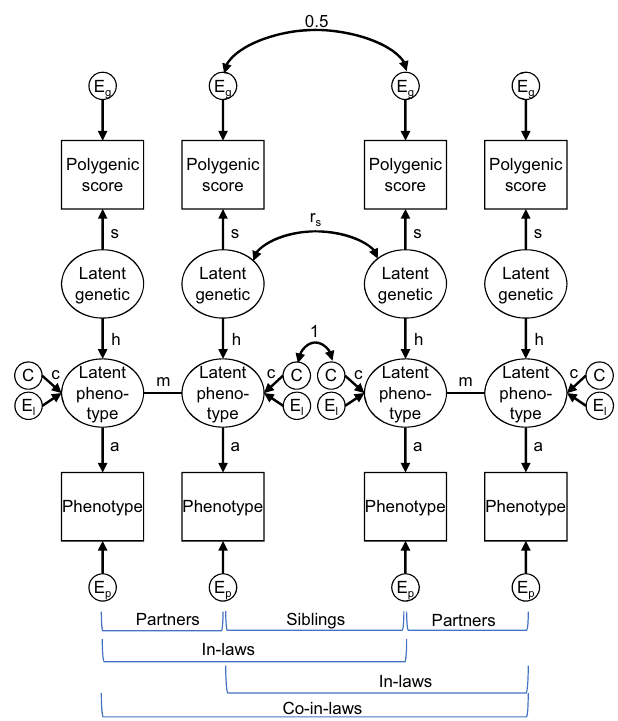
Fig. 2 The Correlation in Genetic Signal (rGenSi) model. Triangles represent observed variables and ovals represent latent variables. Correlations in genetic signals between relatives can be estimated by following path tracing rules. h = in fl uence of latent genetic factor on phenotype, heritability when squared; s = in fl uence of latent genetic factor on polygenic score, genetic signal; m = partner similarity in mated phenotype; a = association between mated and measured phenotype; r s = correlation between siblings ’ latent genetic factors; C = shared environmental variance; c = in fl uences of shared environment; Eg = residual variance of polygenic score (not related to latent genetic factor); El = residual variance of latent phenotype (not related to latent genetic factor); Ep = residual variance of phenotype (not related to mated phenotype). A restricted version of the model can be estimated by constraining c to 0.00 and a to 1.00; otherwise, these can be freely estimated. Variances are fi xed to 1. The residual correlation between siblings ’ polygenic scores (here fi xed to 0.50) can be freely estimated if in fl uences of C are fi xed to considerably higher than the correlation between polygenic scores ( r = 0.11, 95% CI 0.10, 0.12). Genetic correlations were also found for in-laws ( r = 0.25, 95% CI 0.14, 0.46) and co-in-laws ( r = 0.09, 95% CI 0.03, 0.31). For height, the partner correlation